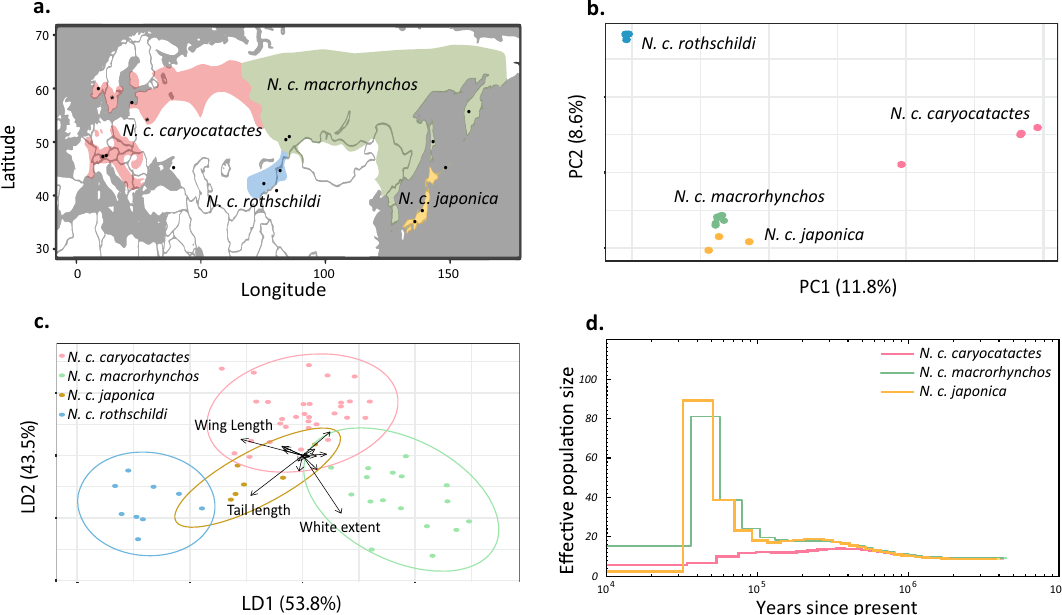
Fig. 3 Genetic and morphometric differentiation within the northern N. caryocatactes group. a Distribution of the four subspecies within the northern N. caryocatactes group. Two specimens sampled in the range of N. c. caryocatactes were taxonomically and genetically identi fi ed as N. c. macrorhynchos . b PCA based on 142,799 SNPs separated the northern N. caryocatactes nutcrackers in three clusters. The specimen located in the middle of N. c. caryocatactes and N. c. macrorhynchos / N. c. japonica re fl ects a potential F1-hybrid. c Linear discriminant analyses based on morphometric measurements of 63 northern N. caryocatactes museum specimens. d Reconstruction of historical effective population size through time based on PSMC. N. c. rothschildi was excluded due to limited genome Genetic, phylogenetic and morphometric comparison between characterized by variation in tail length. Comparison of beak Eurasian nutcracker subspecies . We performed both PCA and traits revealed only a weak yet signi fi cant difference in bill morphology (Welch ’ s t -test p ≤ 0.05), with shorter and higher admixture analyses for the northern and southern N. car- bills in the southern N. caryocatactes nutcrackers compared to yocatactes groups separately to examine genetic differentiation at the northern N. caryocatactes nutcrackers (Supplementary the subspecies level (Figs. 3 and 4). PCA based on 142,799 SNPs Fig. 11). identi fi ed three clusters within the northern N. caryocatactes